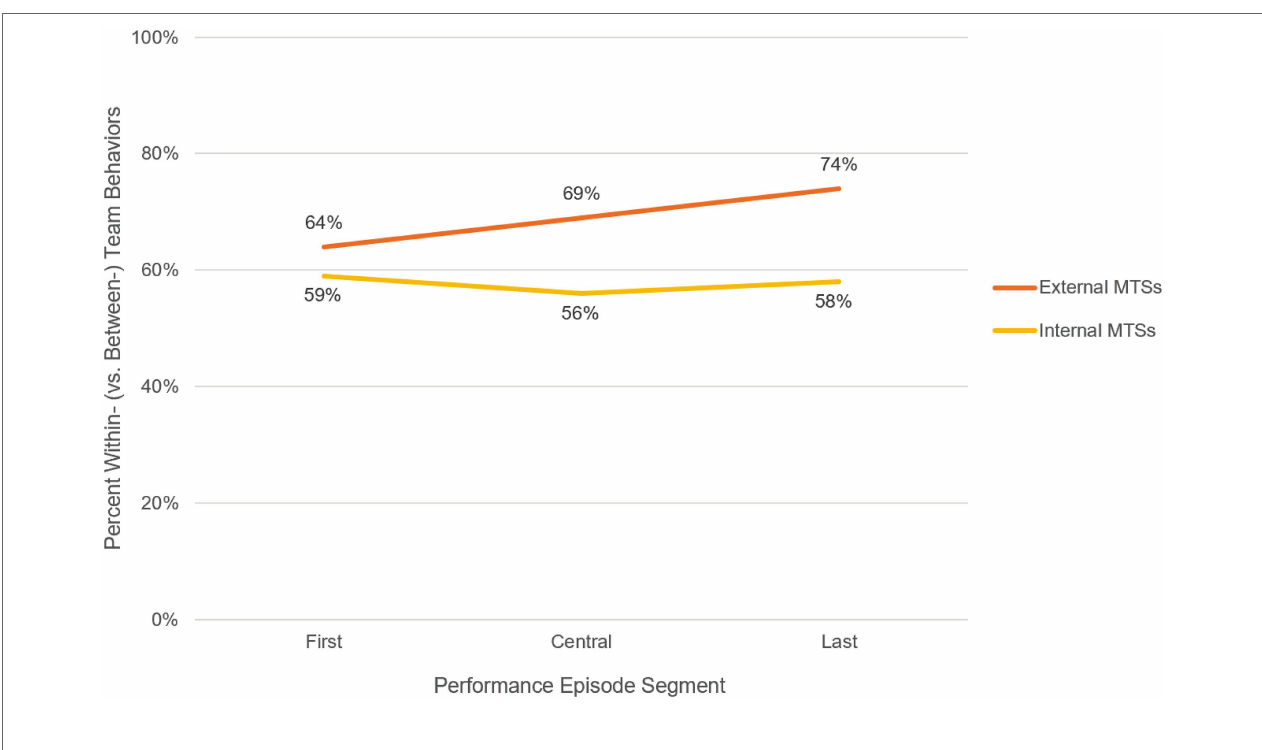
FIGURE 3 | Change in Within vs. Between Behaviors over the Action Phase of the Performance Episode by MTS Boundary Status. The y-axis represents the percentage of within-team behaviors, relative to the percentage of between-team behaviors. The x-axis indicates the coded behaviors that occurred within each section of the performance episode. For example, the furthest right data point on the lower line indicates that, for all coded behaviors in the last third of the performance episode, for cases of performance for MTSs with internal boundary status, the behaviors were 58%